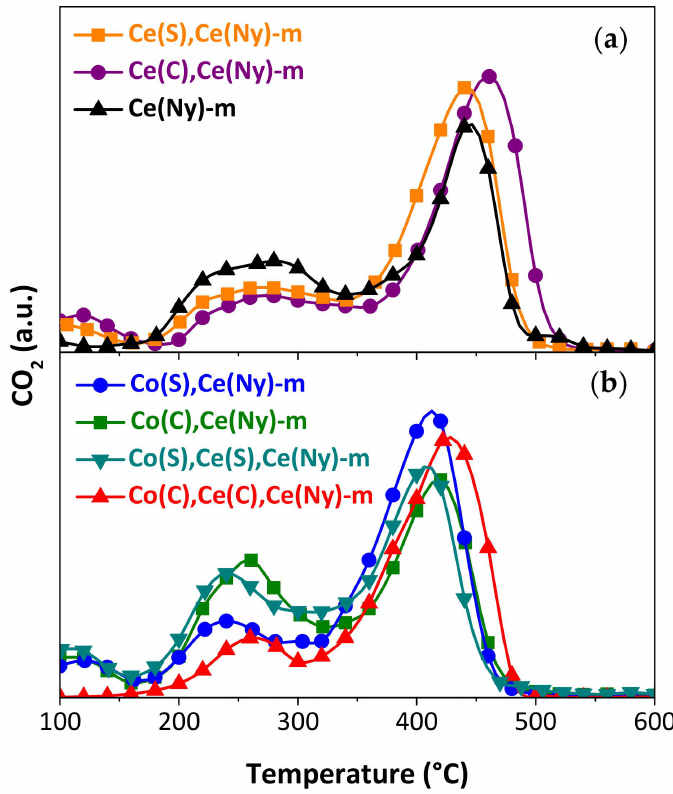
Figure 8. TPO curves of stacked wire mesh catalytic structures: ( a ) CeO 2 and ( b ) Co,Ce